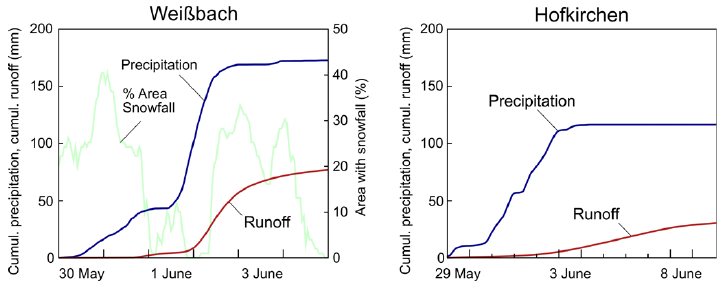
Fig. 6. Cumulative precipitation (blue lines) and cumulative runoff depths (red lines, direct runoff only) for the June 2013 flood event. Light green line in the left panel shows the catchment area with temperatures below 0 ◦ C. (left) Weißbach catchment (567km 2 ), (right) Hofkirchen catchment (45610km 2 ).